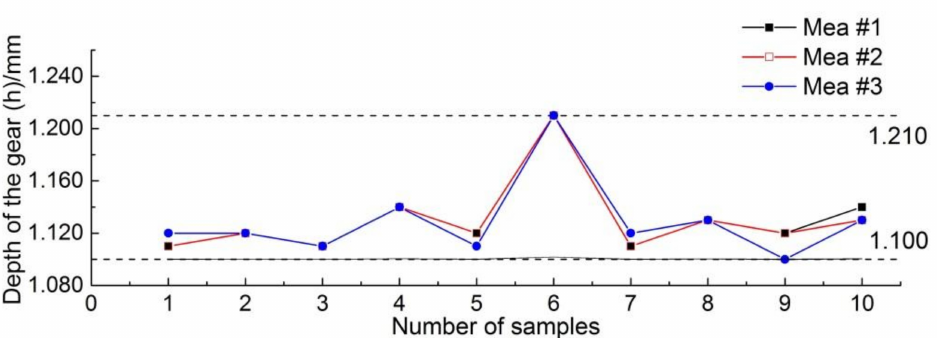
Figure 10. The depth of the 10 gears measured by the first operator (three measurements for each